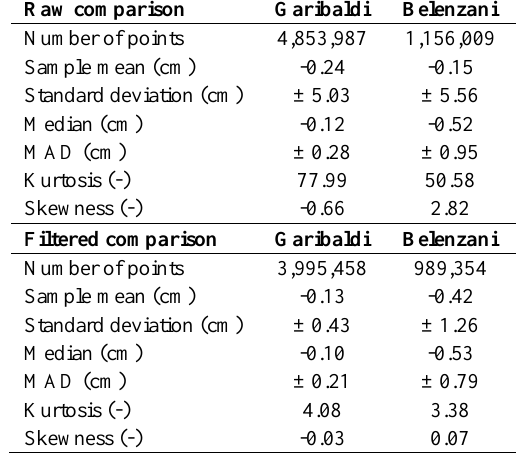
Table 5. Statistical results of the accuracy evaluation: MMS vs. TLS for the street dataset on the raw and filtered point clouds.